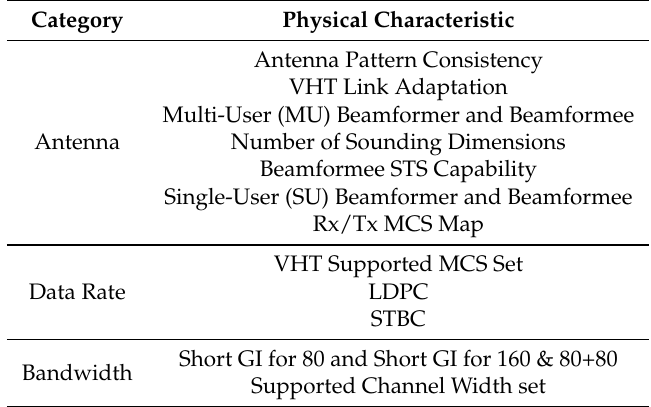
Table 1. Physical